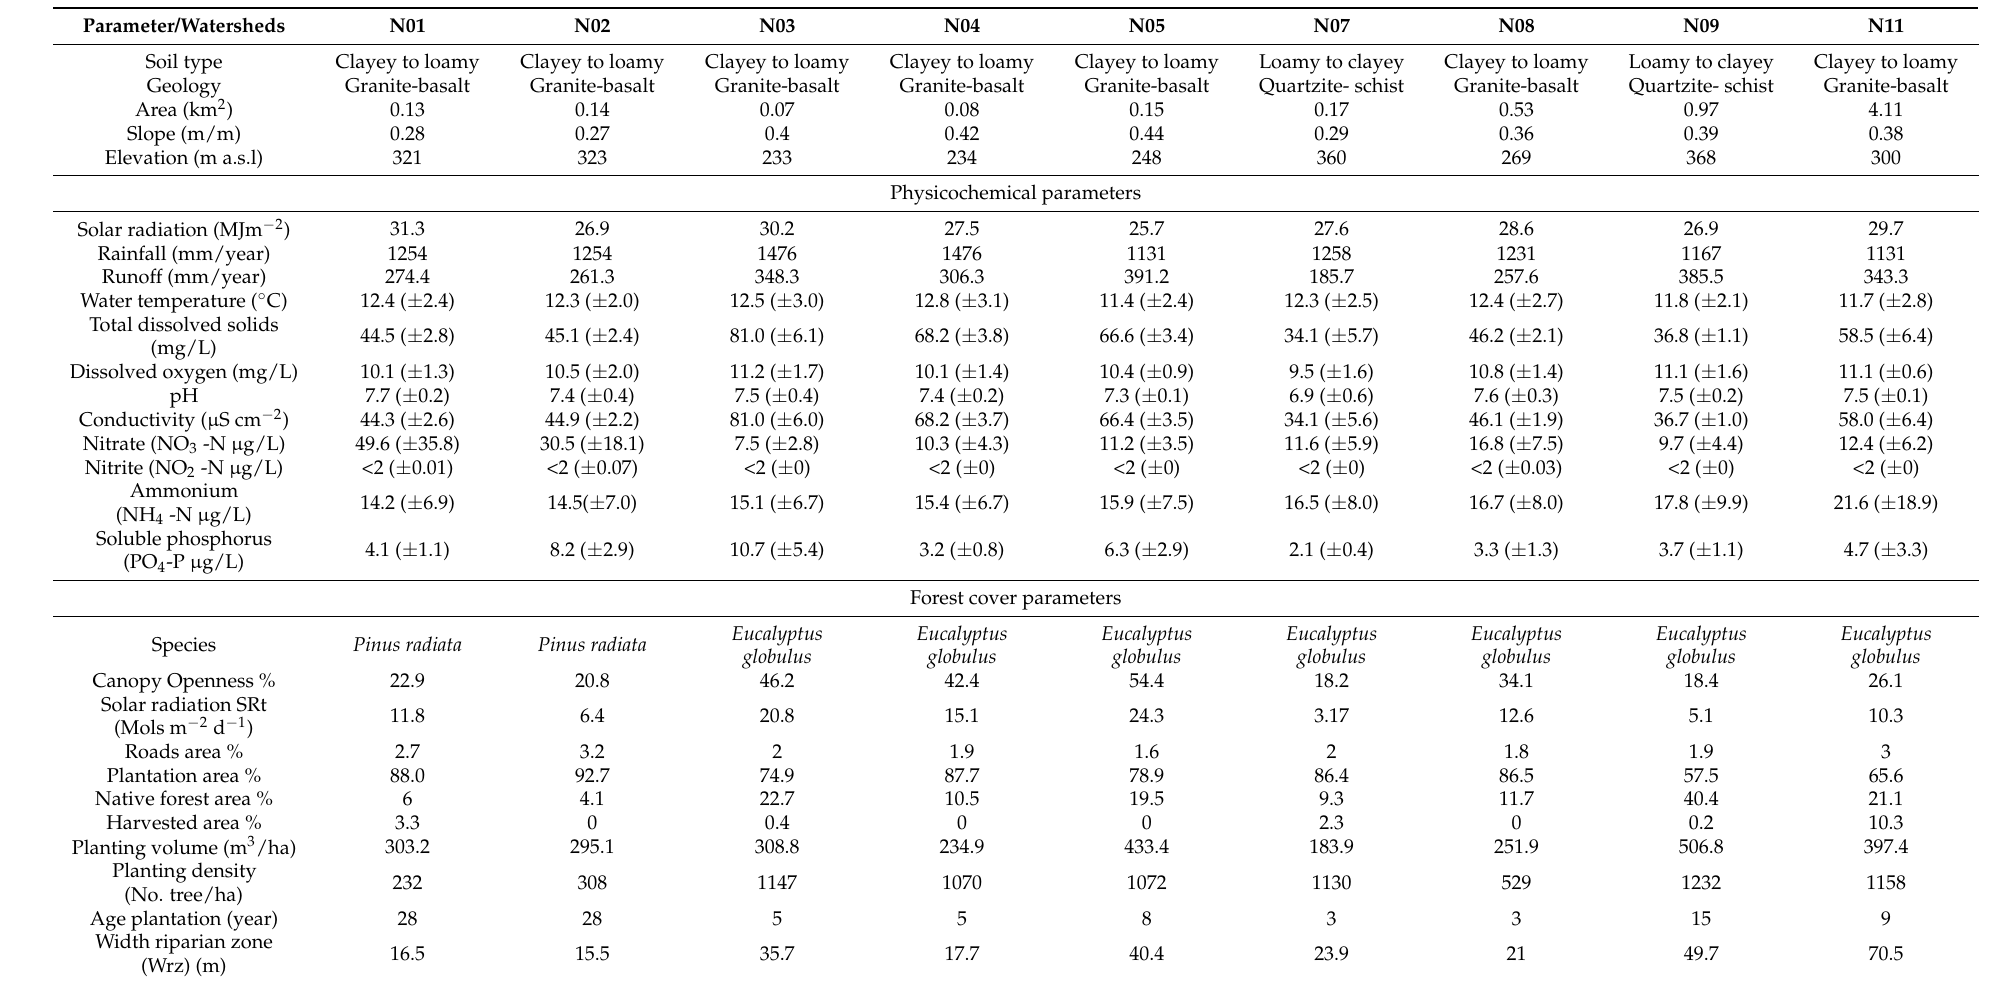
Table 1. Physicochemical and forest cover parameters of studied